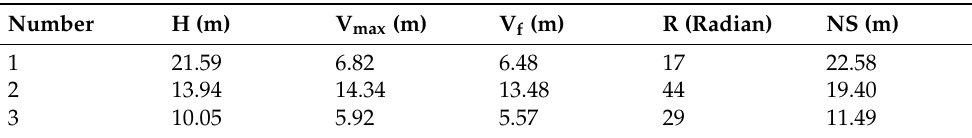
Table 1. The mean of the displacements obtained in the gully area due to Doroud Fault activity. H(m) = cumulative horizontal displacement; Vmax (m) = cumulative displacement of the slope on the ground; Vf (m) = displacement of the slope collapse on the fault surface; R (Radian) = rake angle; NS (m) = cumulative displacement fault slip (net slip).